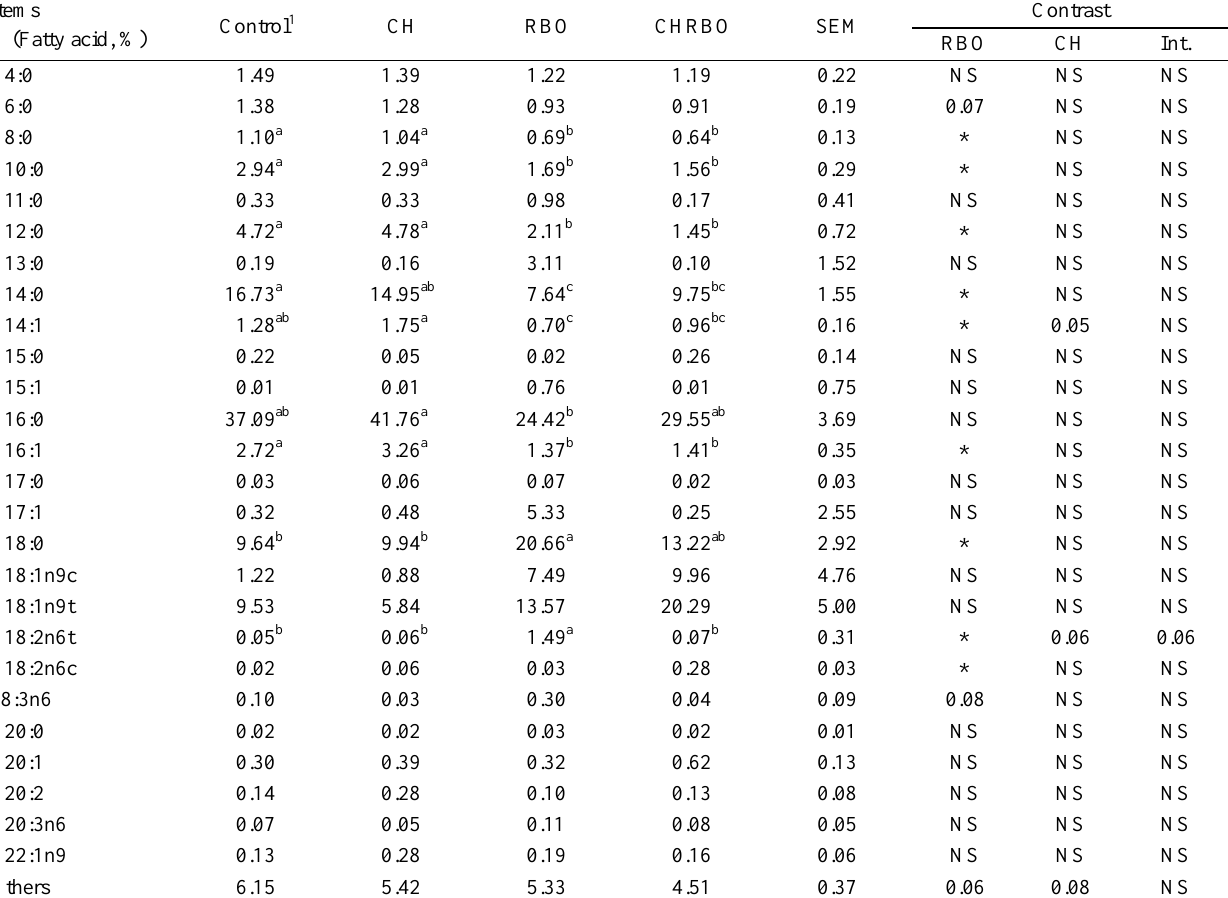
Table 7. Effect of cassava hay and rice bran oil on fatty acids composition in lactating dairy cows Items